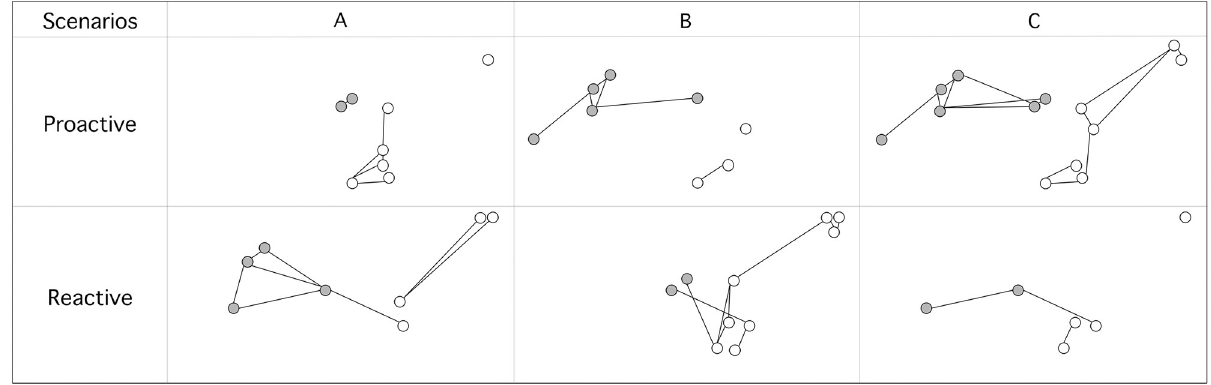
Fig 3. Different population subgraphs based on distinct node selection parameters using a proactive or reactive conservation approach. A: Node selection based on heterozygosity (H E ) values. B: Node selection based on estimated population size. C: Node selection based on element occurrence (EO) values. For each of these experimental scenarios, nodes included in the subgraph represented populations with the largest (Proactive) or smallest (Reactive) parameter values. Populations located on the northern and southern shores of the St. Lawrence River are identified with gray and white nodes,